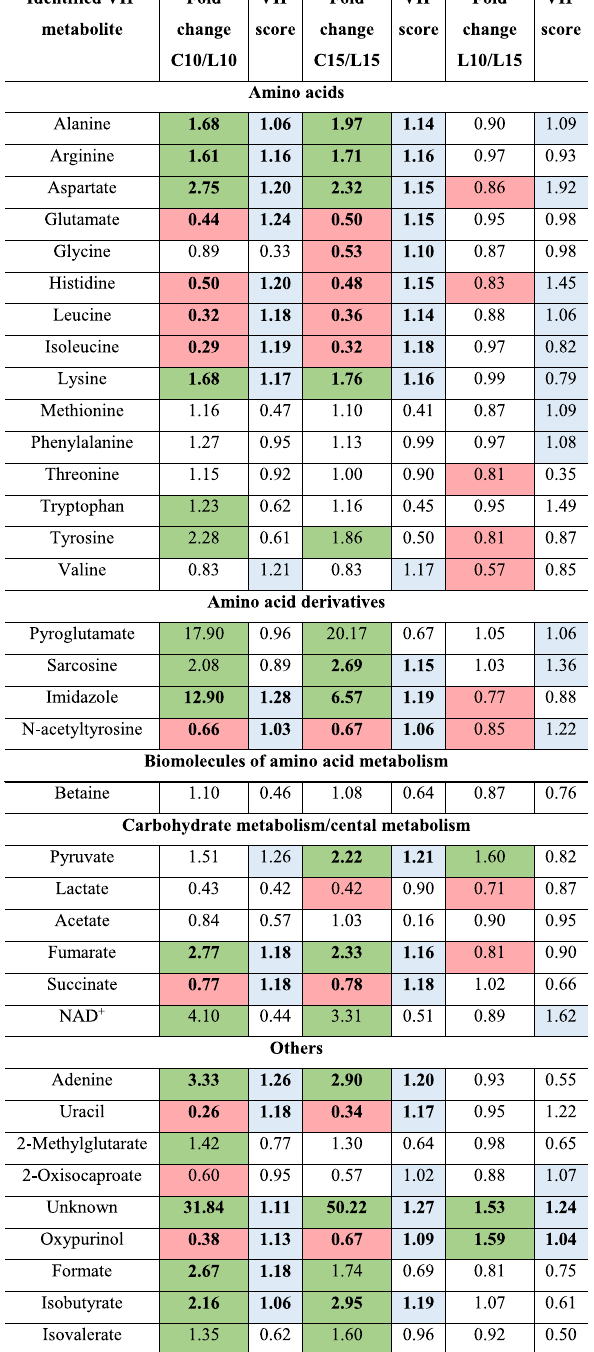
Table 4. The statistical and multivariate data analysis for identified metabolites before and after multiple lethal exposures of A. baumannii to aPDT (increased levels of metabolites with p value < 0.05 are marked in red; decreased levels of metabolites metabolites with p value < 0.05 are marked in green; VIP values > 1.00 are marked in grey; metabolites with p value < 0.05 and VIP value > 1.00 are bolded). C10 or C15- cultures before phototherapies, after ten or fifteen inoculations. L10 or L15- cultures after ten or fifteen lethal